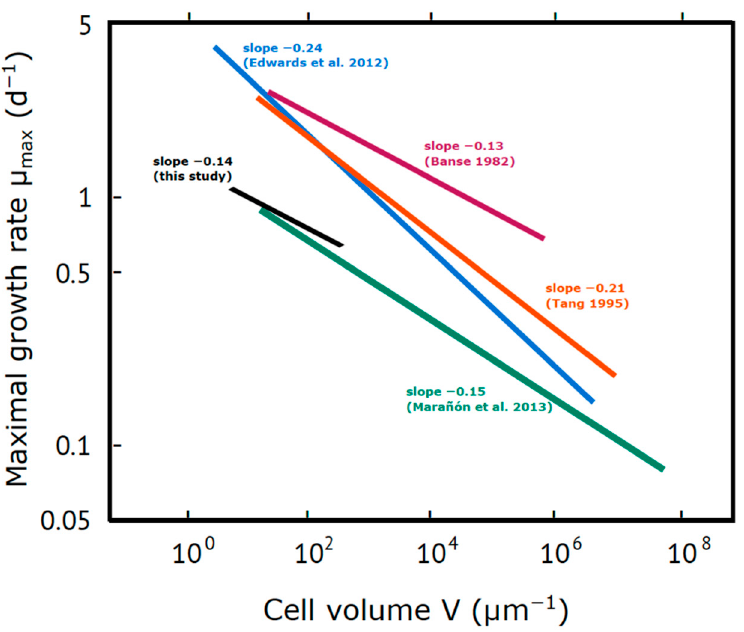
Figure 4. Graphical comparison of relationship between phytoplankton maximal growth rates and cell size resulting from this study (black line) and literature sources (measured at or recalculated for 18–20 °C).